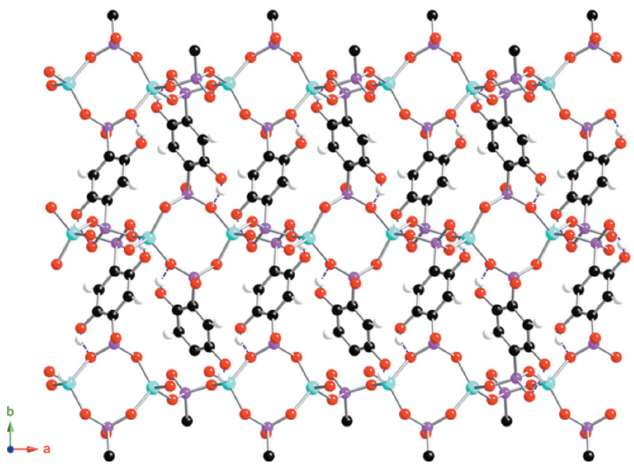
Figure 3 Ball-and-stick representation of the structure of (I) viewed along the [001] axis. The hydrogen bonds involving the –OH groups are drawn as blue dashed lines. Color key as in Fig.